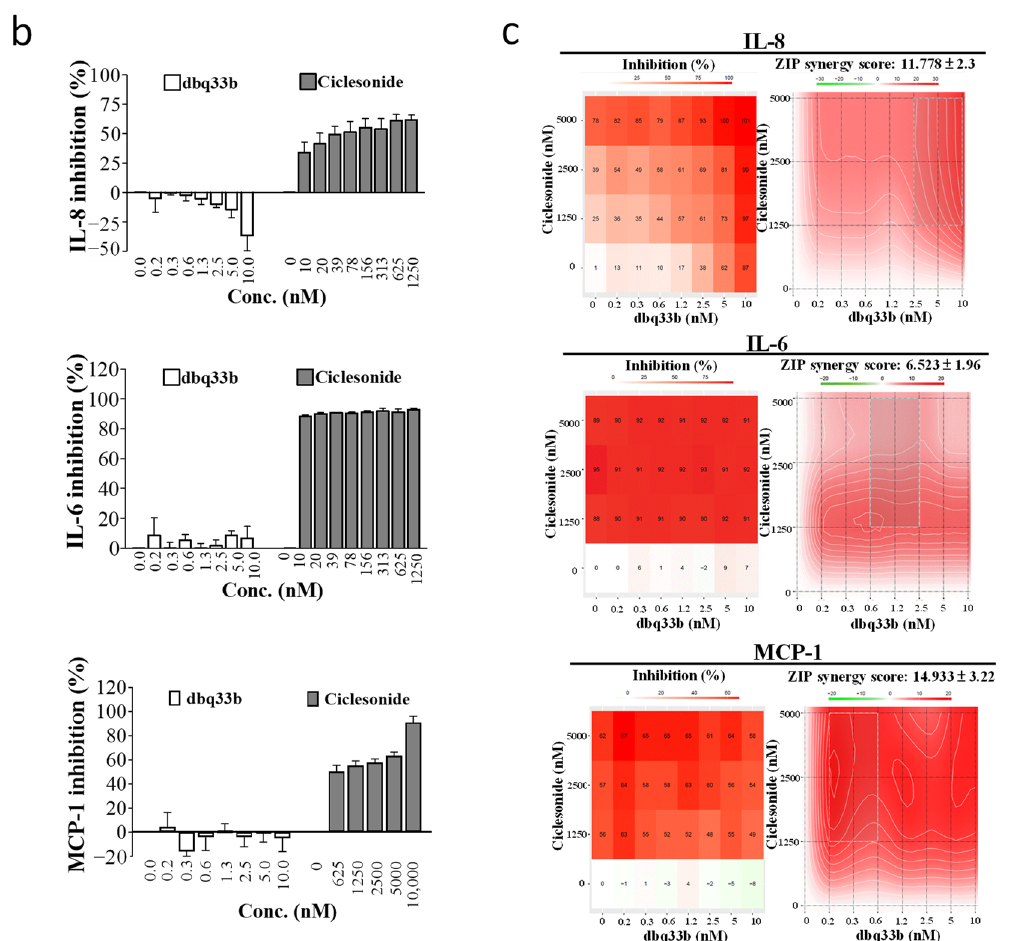
Figure 4. The effects of ciclesonide and tylophorine-based dbq33b, respectively, alone or in combi- nation on the cytokine productions in HCoV-OC43-infected MRC-5 cells. ( A ) IL-8, IL-6, and MCP-1 were highly induced and produced in MRC-5 cells upon HCoV-OC43 infection at 30 h.p.i. ( a ) The changes in culture supernatant levels of 42 cytokines with or without HCoV-OC43 infection were evaluated using a cytokine array (Abcam, ab133997) from HCoV-OC43-infected cells and control cells at 30 h.p.i. ( b ) ELISA kits with high specificity as indicated were used to verify and evaluate the identified cytokine productions from ( a ). ( B ) The effects of ciclesonide and tylophorine-based dbq33b, separately or in combination, on the cytokine productions of IL-6, IL-8, and MCP-1. ( a ) IL-8, IL-6, and MCP-1 were highly produced in MRC-5 cells upon HCoV-OC43 infection over a period of three days. ( b ) The respective dosage effects of ciclesonide and tylophorine-based dbq33b on the sentative of three independent experiments and AVE ± S.D. from three independent experiments.